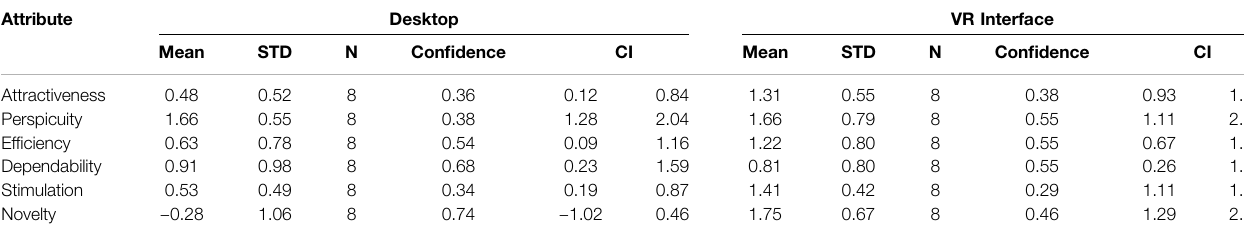
TABLE 1 | Results of the User Experience Questionnaire for Desktop and VR. Attribute Desktop VR Interface